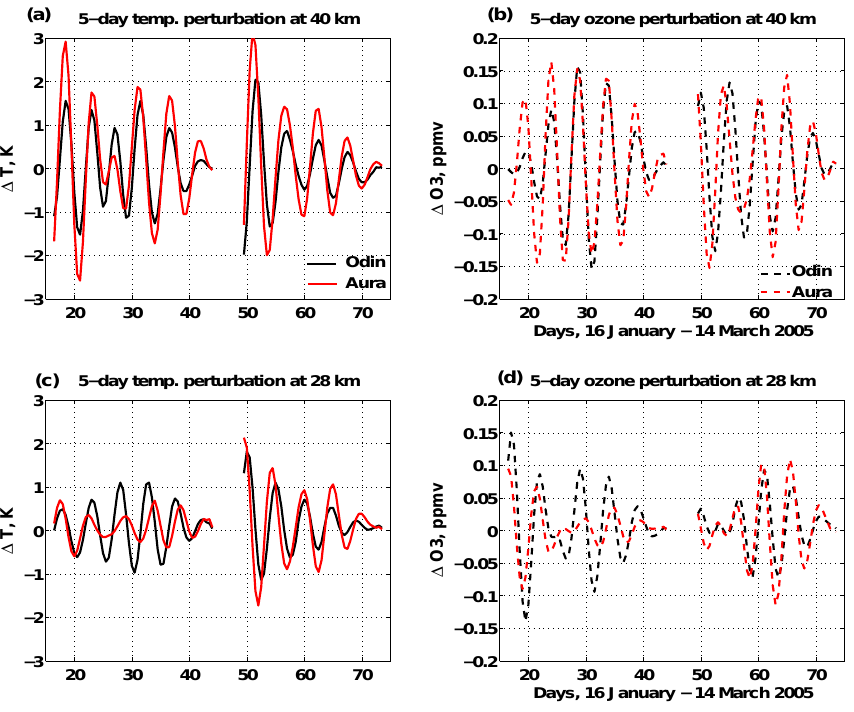
Fig. 17. 5-day perturbations in temperature (left-hand panel) and ozone (right-hand panel) at 28km (lower panel) and at 40km (upper panel), at 60 ◦ N from Odin SMR data (black line) and Aura MLS data (red